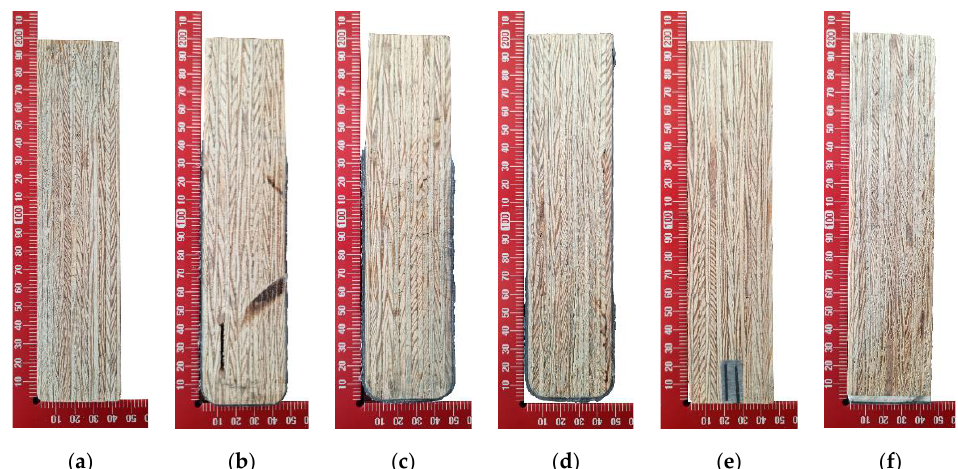
Figure 2. Selected cross-section cut out of tested beams: ( a ) unreinforced beam (A series); ( b ) beam reinforced with one layer of CFRP sheet; ( c ) beam reinforced with two layers of CFRP sheet bonded in tension zone; ( d ) beam reinforced with two layers of CFRP sheet covering entire side surface with overlap in tension zone (D series); ( e ) beam reinforced with two CFRP laminate inserts bonded into pre-drilled grooves (E series); ( f ) beam strengthen with CFRP laminate bonded to bottom side (F series).